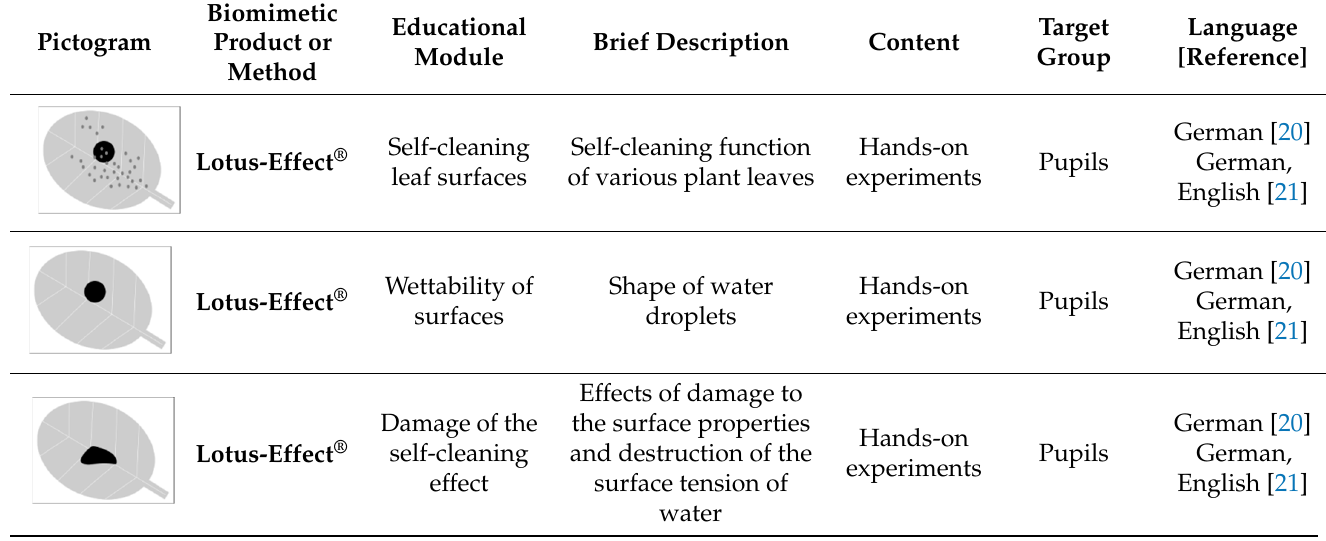
Table 3. Educational modules of well-known biomimetic products and methods developed for various target groups. All modules have instructions for and evaluations of the experiments, model solutions, and explanations (abbreviated as “Hands-on experiments”).